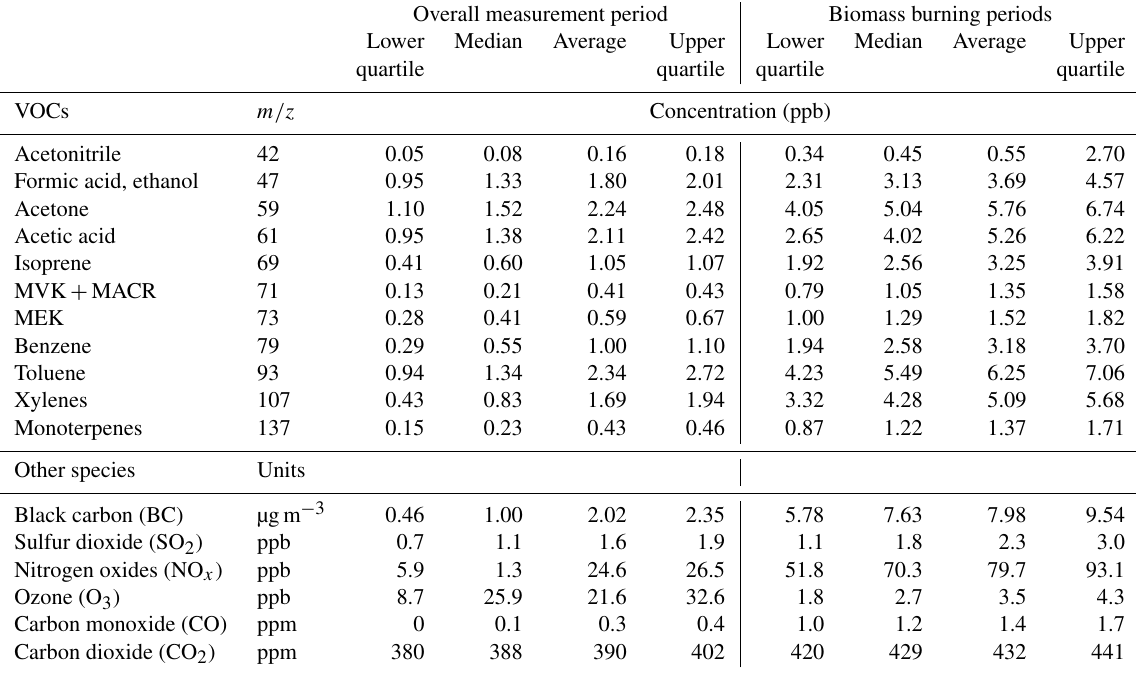
Table 3. Concentrations (5min averages) of VOCs and other pollutants during the Athens winter campaign. Values are shown for the overall period and for the biomass burning periods.